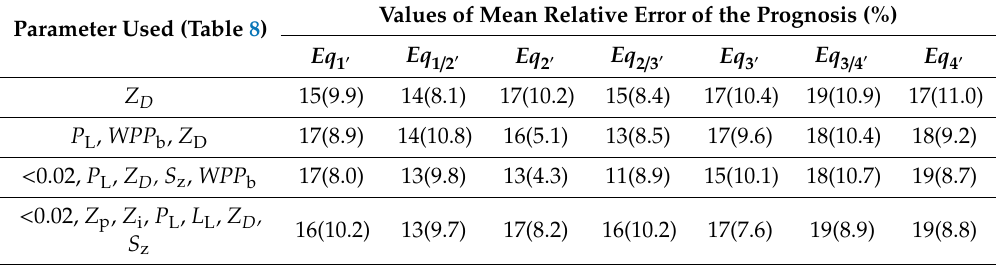
Table 9. Values of mean relative error of the prognosis ( δ p ) for particular equations E qx ’ (Table 7) using selected combinations of criteria listed in Table 8 and data contained in the validation